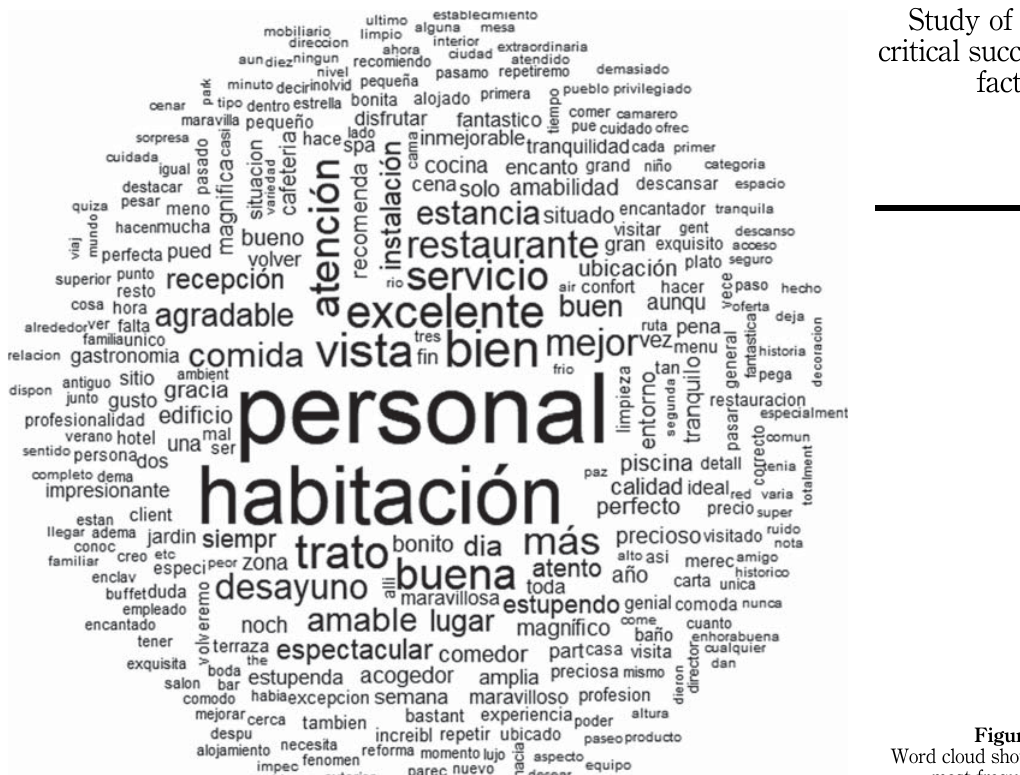
Figure 2. Word cloud showing most frequently used